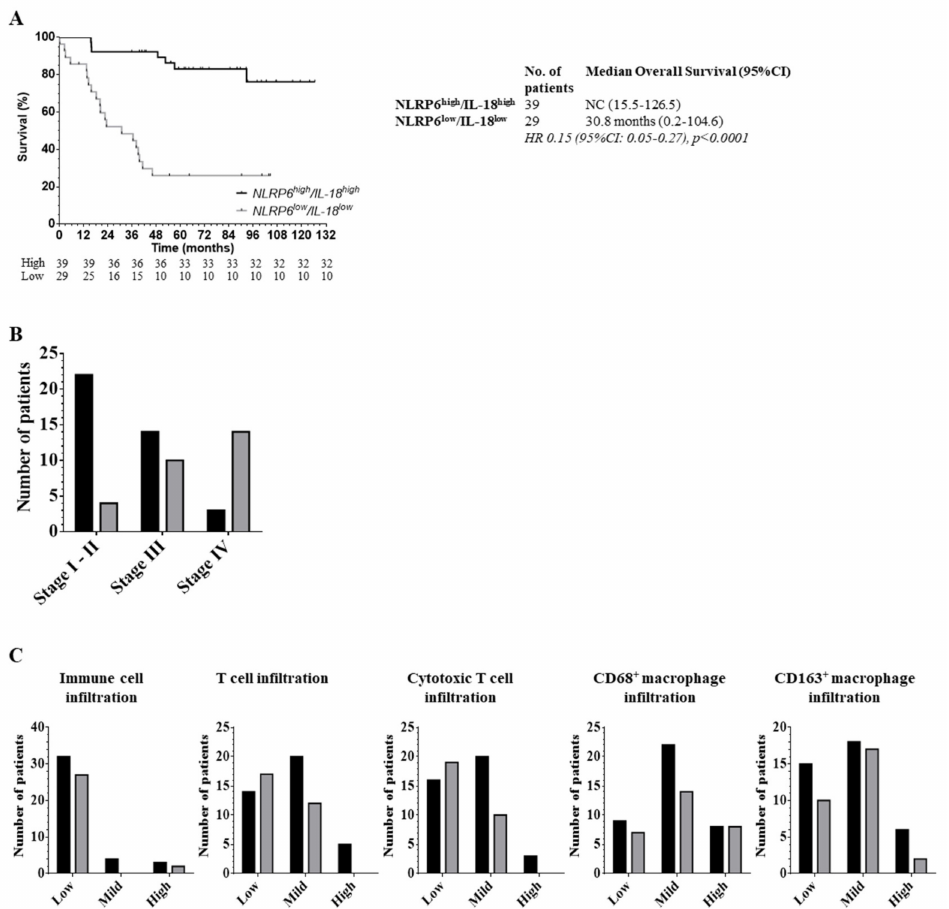
Figure 5. Downregulation of epithelial NLRP6 / IL-18 is associated with a more advanced disease. ( A ) Overall survival of colorectal cancer patients based on NLRP6 / IL-18 protein profile. NLRP6